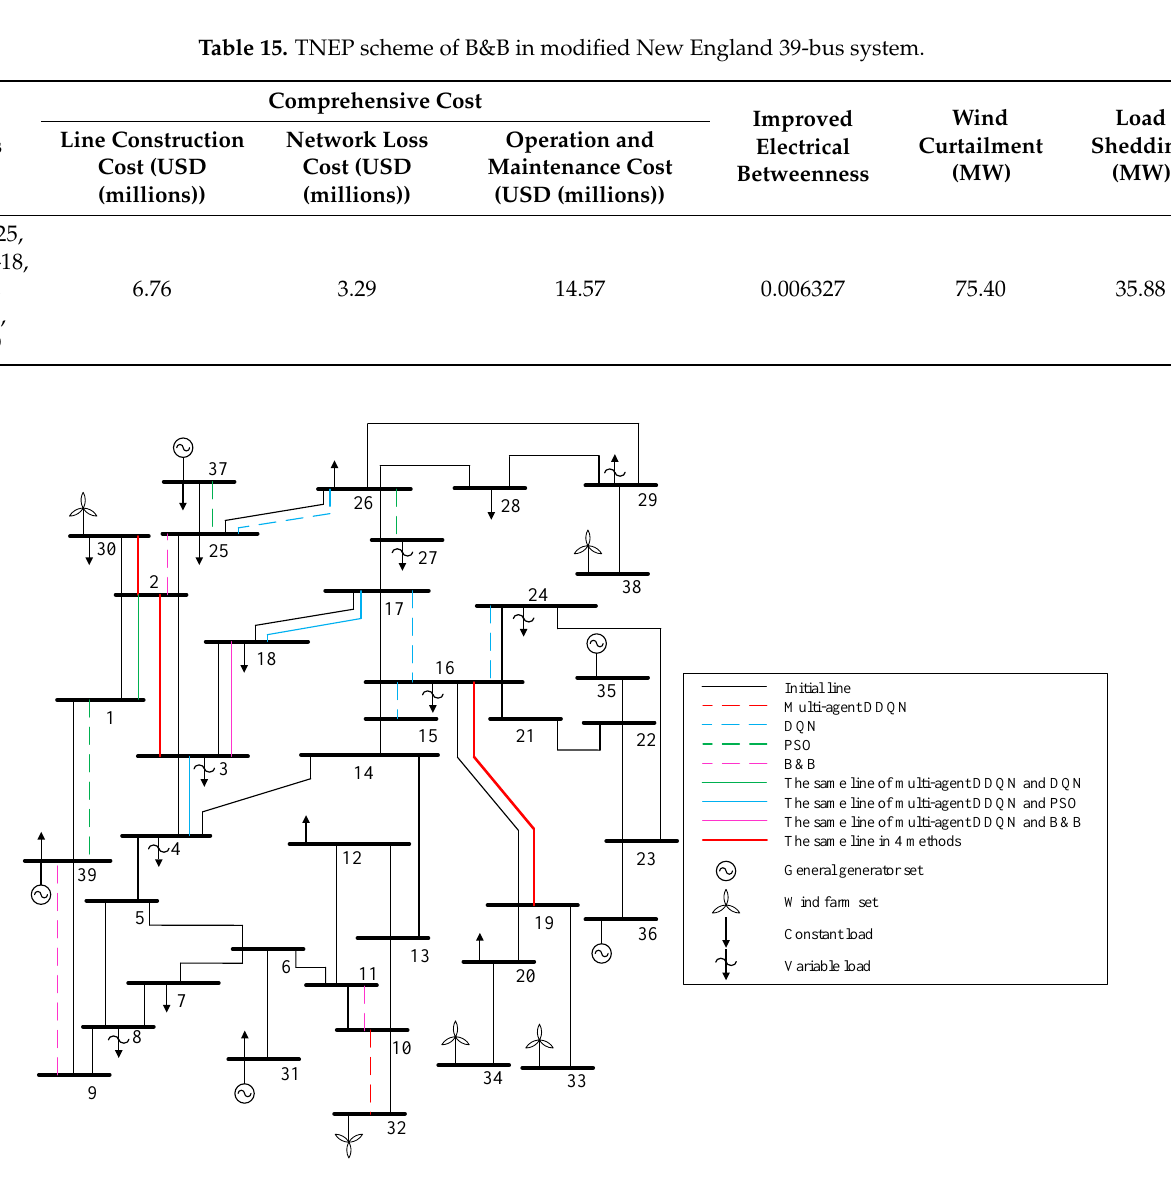
Figure 15. TNEP scheme of four methods in modified New England 39-bus system. The generator sets of the modified New England 39-bus system are settled at the edge of the system, but the load nodes are evenly distributed. Under the uncertain scenarios,